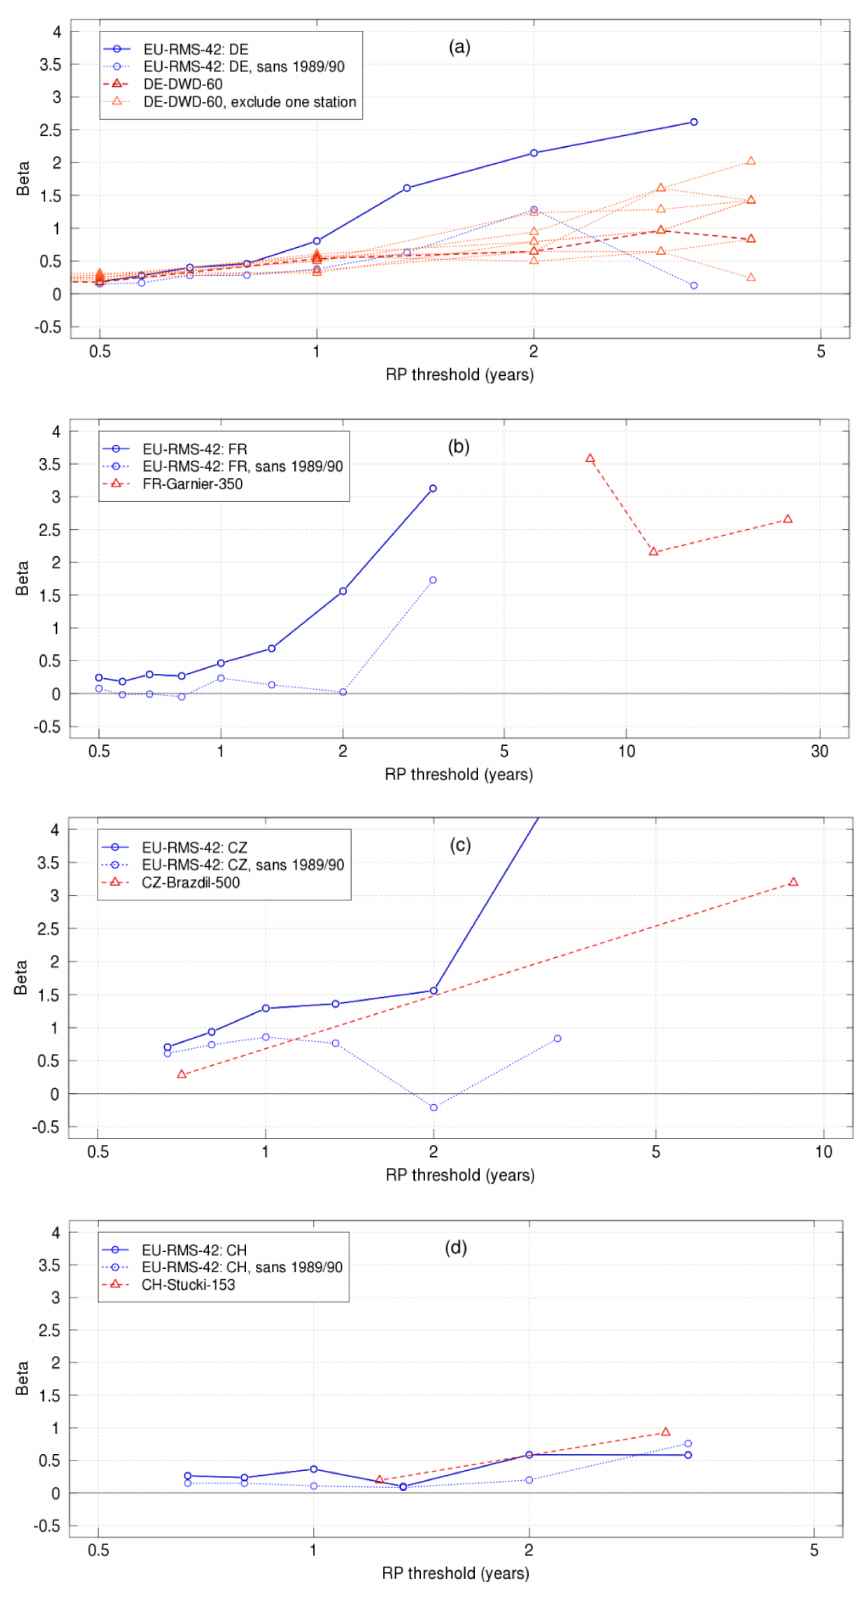
Figure 10. Clustering strength ( β ) as a function of storm severity for (a) Germany, (b) France, (c) Czech Republic, and (d) Switzerland.